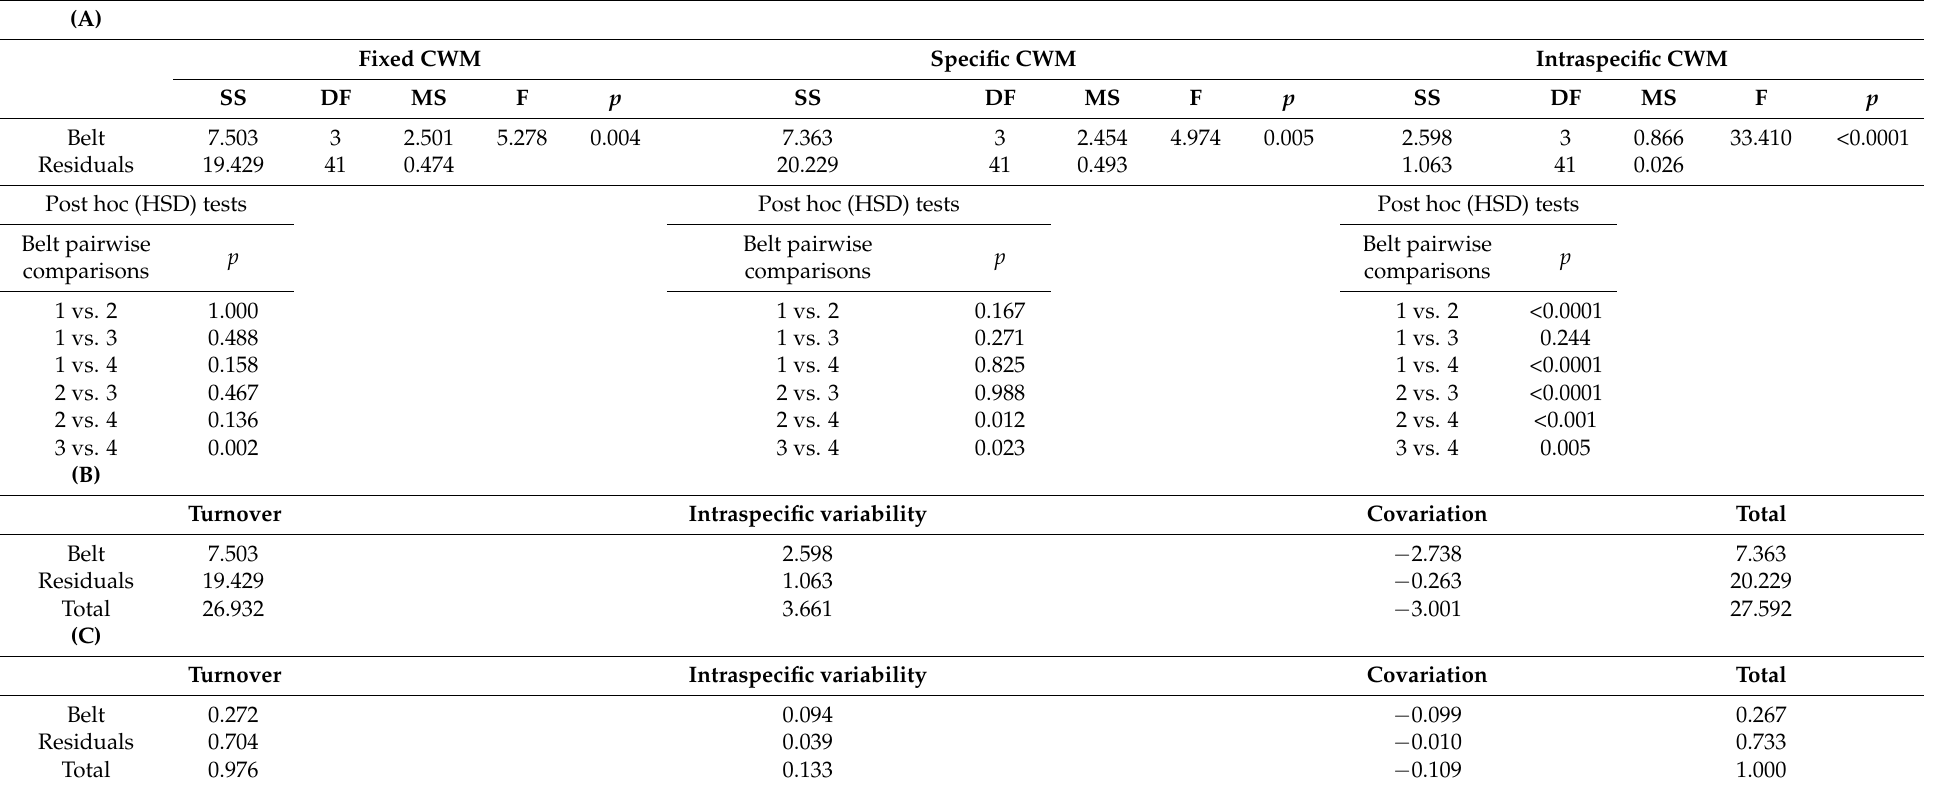
Table 5. Results of ANOVAs for CWM of seed mass (SM). ( A ) ‘Fixed’ and ‘specific’ averages and intraspecific variability effect were analyzed separately (one-way ANOVA), followed by post hoc (HSD) tests for pairwise comparisons. ( B ) Variability of individual components of trait variation (turnover, intraspecific and their covariation) between belts. ( C ) Proportions of variability of individual components and their parts explained by elevation (belt). For details, see Table